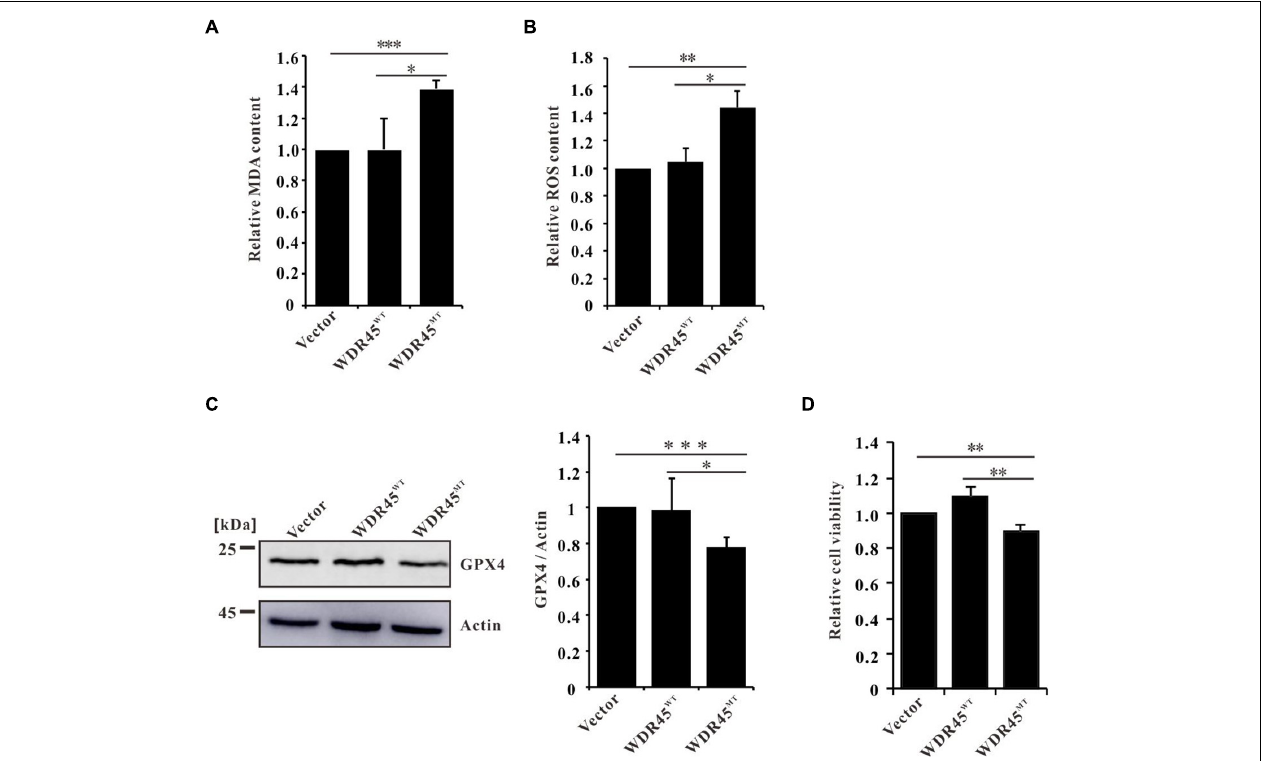
FIGURE 4 | WDR45 deficiency induces ferroptosis. (A) Malondialdehyde (MDA) content was significantly increased in WDR45 MT expressing cells. (B) Reactive oxygen species (ROS) content was significantly increased in WDR45 MT expressing cells. (C) Glutathione peroxidase 4 (GPX4) was significantly lowered in WDR45 MT expressing cells. (D) Cell viability was decreased in WDR45 MT expressing cells. * p < 0.05; ** p < 0.01; *** p <